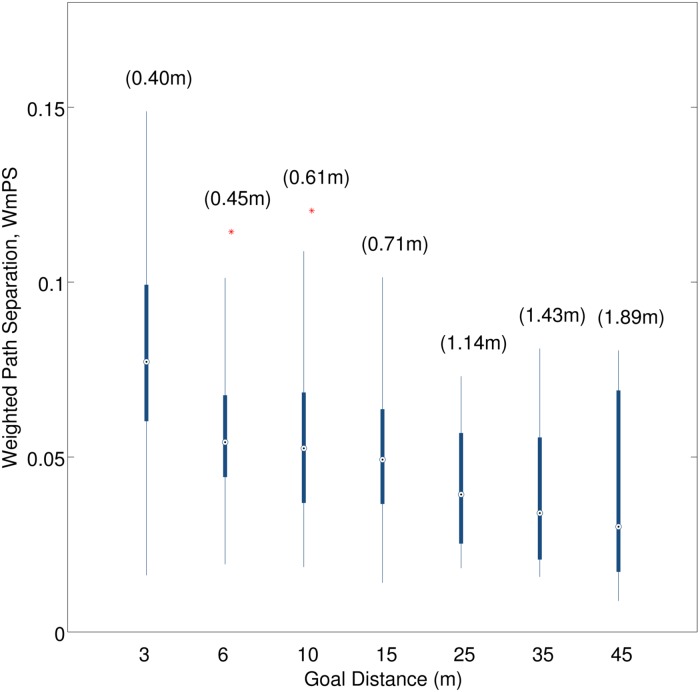
Weighted mean path separation (WmPS)—DtD & GLD trials.WmPS is plotted as a function of the goal distance. Box-plot whiskers represent 1.5 times the interquartile range, red crosses indicate outliers. Numbers in brackets indicate the mean path separation (mPS) at the corresponding goal distance.